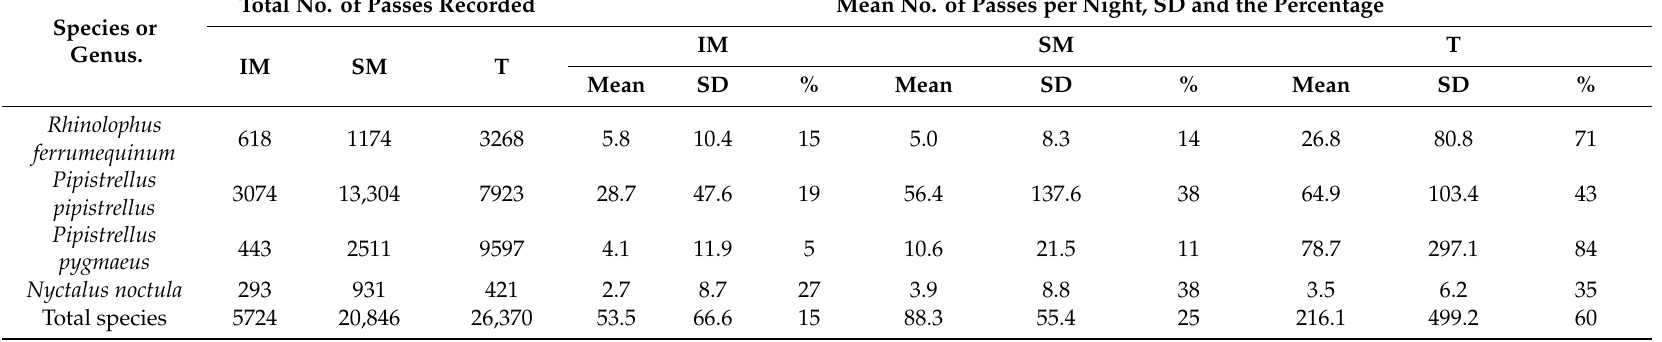
Table 2. A comparison of bat species activity between the three di ff erent types of linear features: intensively managed hedgerows (IM), sympathetically managed hedgerows (SM) and treelines